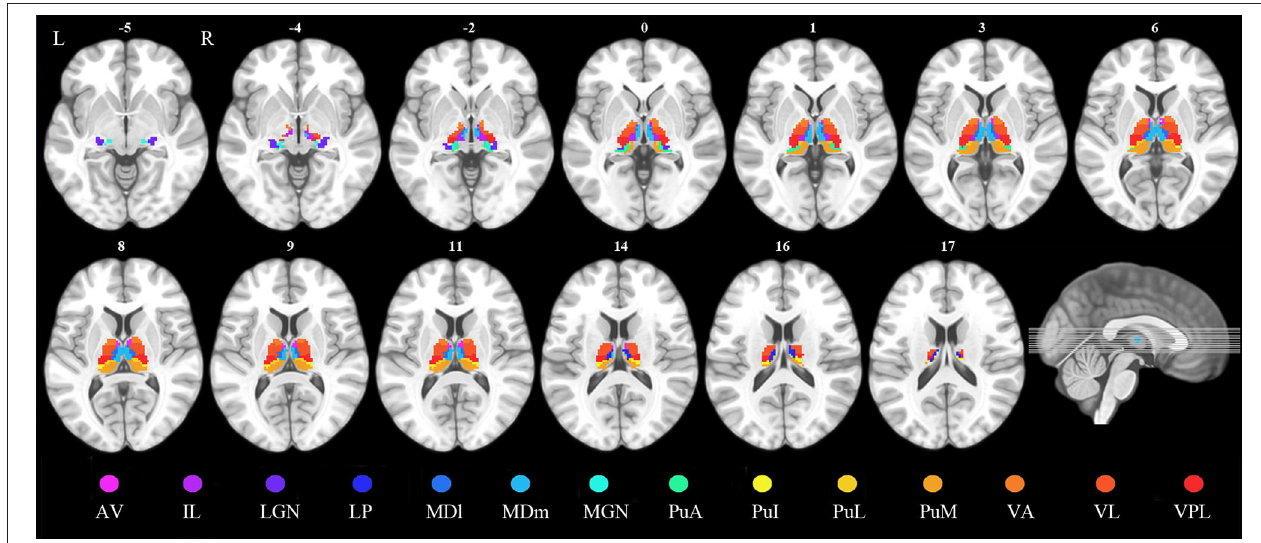
FIGURE 1 | Definition of the thalamic nuclei. AV, anteroventral nuclei; IL, intralaminar nuclei; LGN, lateral geniculate; LP, lateral posterior nuclei; MDl, mediodorsal lateral parvocellular nuclei; MDm, mediodorsal medial magnocellular nuclei; MGN, medial geniculate nuclei; PuA, pulvinar anterior nuclei; PuI, pulvinar inferior nuclei; PuL, pulvinar lateral nuclei; PuM, pulvinar medial nuclei; VA, ventral anterior nuclei; VL, ventral lateral nuclei; VPL, ventral posterolateral nuclei.